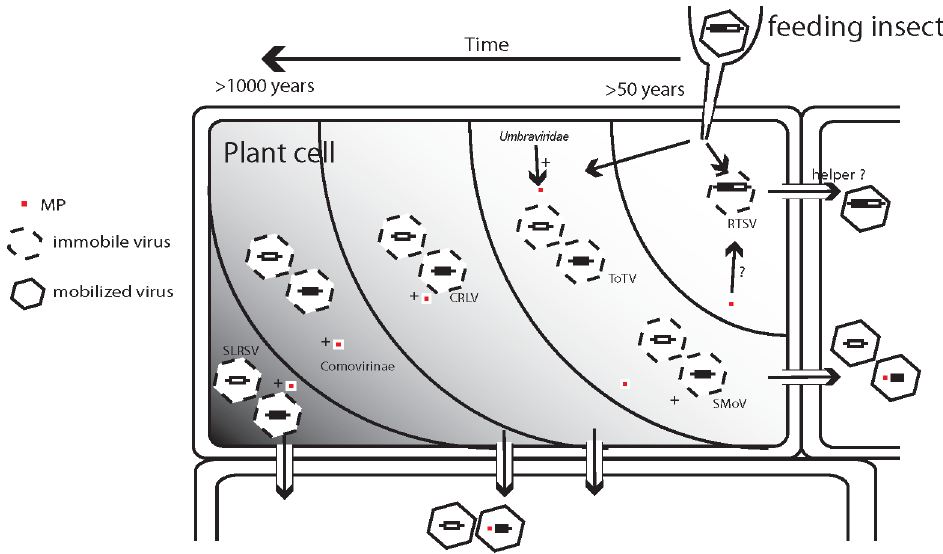
Figure 7. Putative model of colonization of plants by the Secoviridae. Cherry rasp leaf virus (CRLV), Rice tungro spherical virus (RTSV), Strawberry mottle virus (SMoV), Strawberry latent ringspot virus (SLRSV), Tomato torrado virus (ToTV). Time scale of years increasing from right to